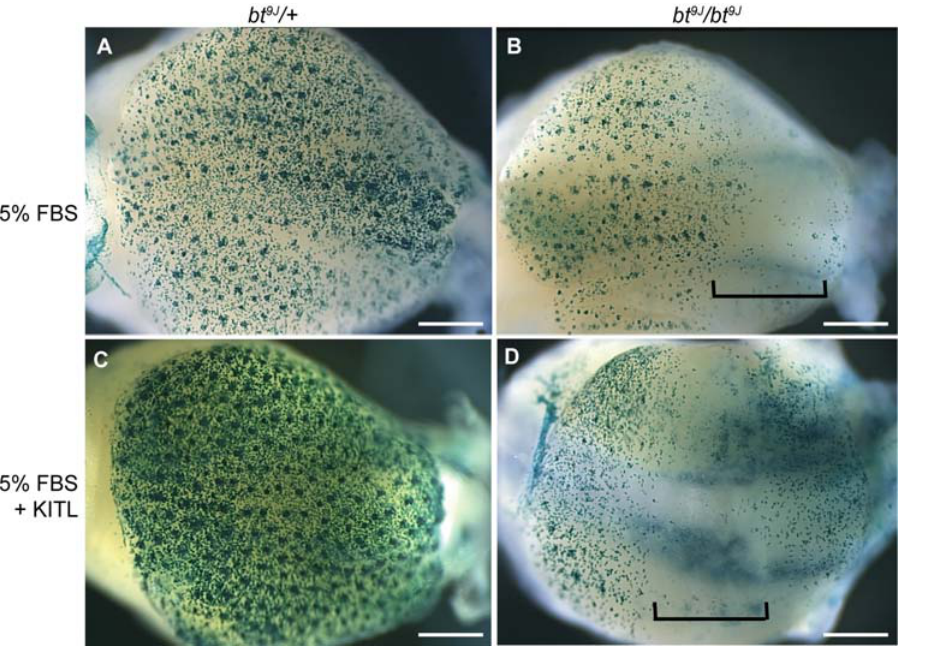
Figure 6. Melanoblasts in bt 9J /bt 9J skin do not respond to soluble Kitl. (A–D) Images of b -galactosidase stained skin cultures grown from E13.5 bt 9J / + ;Dct -LacZ (A,C) or bt 9J /bt 9J ;Dct -LacZ (B,D) embryos, and treated with either 5% FBS (A,B) or 5% FBS + Kitl (C,D). Brackets indicate the presumptive belt regions in bt 9J /bt 9J skin. The scale bars are: (A–D) 0.5 mm.